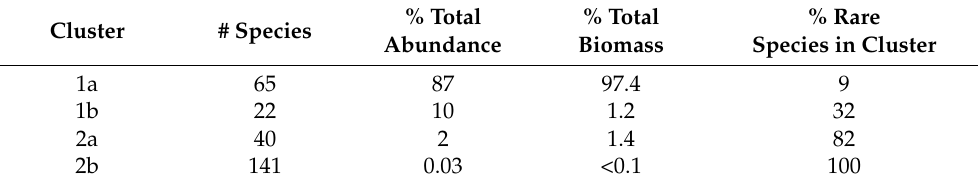
Table 4. Abundance, biomass, and % rare species contributions of major clusters in two-way classification. Cluster # Species